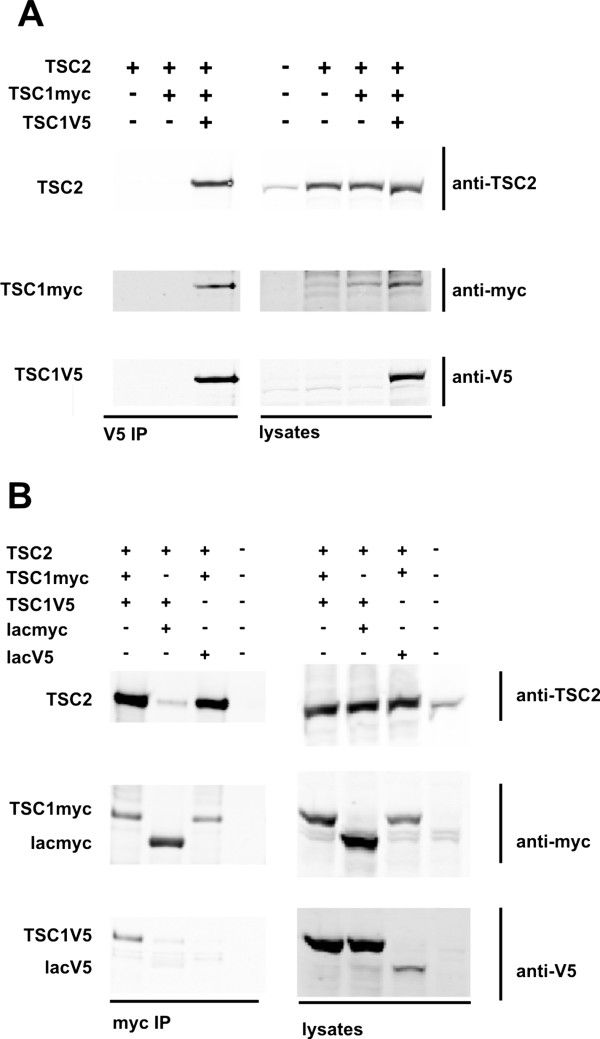
Coimmunoprecipitation of distinct epitope-tagged TSC1 isoforms. TSC1myc and TSC1V5 were co-expressed with TSC2 in HEK293T cells. The distinct tagged TSC1 isoforms were immunoprecipitated and the presence of other coimmunoprecipitated tagged isoforms was investigated by immunoblotting. (A) Coimmunoprecipitation of TSC2 and TSC1myc with TSC1V5. TSC1V5 was co-expressed with TSC2 and TSC1myc. TSC1V5 was immunoprecipitated with anti-V5 affinity beads, washed and the immunoprecipitates analysed by immunoblotting. TSC1myc and TSC2 were detected in the TSC1V5 immunoprecipitate. (B) Coimmunoprecipitation of TSC2 and TSC1V5 with TSC1myc. TSC1myc was co-expressed with TSC2 and TSC1V5 or V5-tagged β-lactamase (lacV5). TSC1myc was immunoprecipitated with anti-myc affinity beads, washed and the immunoprecipitates analysed by immunoblotting. TSC1V5 and TSC2, but not lacV5, were detected in the TSC1myc immunoprecipitate. As an extra control, TSC2 and TSC1V5 were co-expressed with myc-tagged β-lactamase (lacmyc), and immunoprecipitated with anti-myc affinity beads. TSC1V5 was not detected in the lacmyc immunoprecipitate.